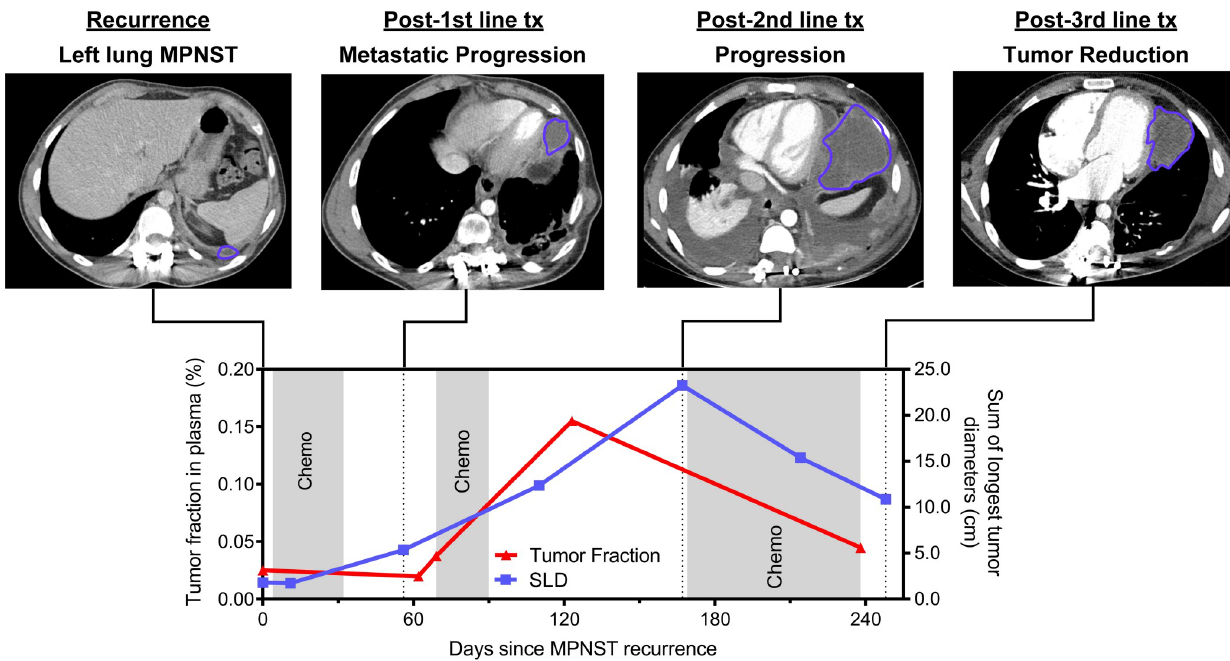
Fig 6. Monitoring tumor burden vignette (sar085). This patient had a high-grade thoracic MPNST recurrence that progressed rapidly through first- and second-line chemotherapy but responded to third-line chemotherapy. Tumor fraction in plasma was initially undetectable, then rapidly increased during first- and second-line chemotherapy, followed by a rapid decrease during third-line chemotherapy. This dynamic tumor fraction in plasma correlated well with the SLD measured radiographically by RECIST 1.1 criteria. Chemo, chemotherapy; cm, centimeters; MPNST, malignant peripheral nerve sheath tumor; SLD, sum of longest tumor diameters; Tx,